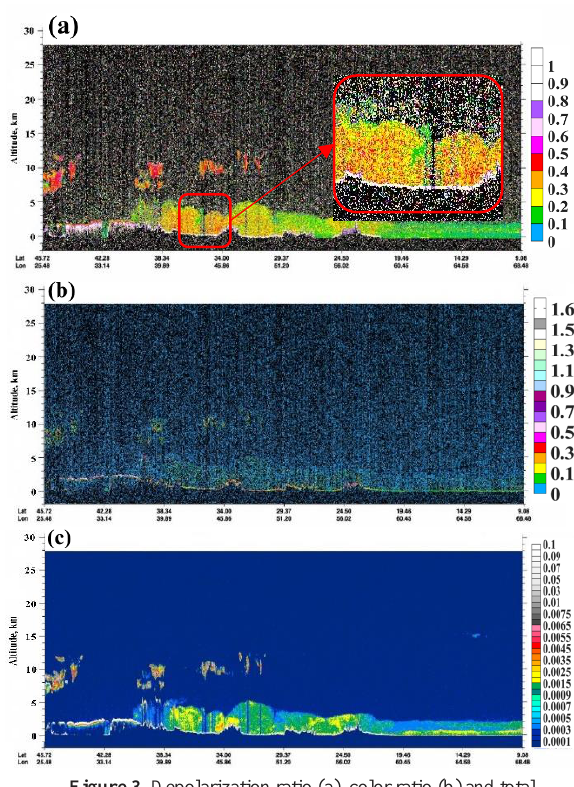
Figure 3. Depolarization ratio (a), color ratio (b) and total attenuated backscatter at 1064 nm (c). Smoke steams form burning oil wells by ISIS has a lower DR and higher backscatter